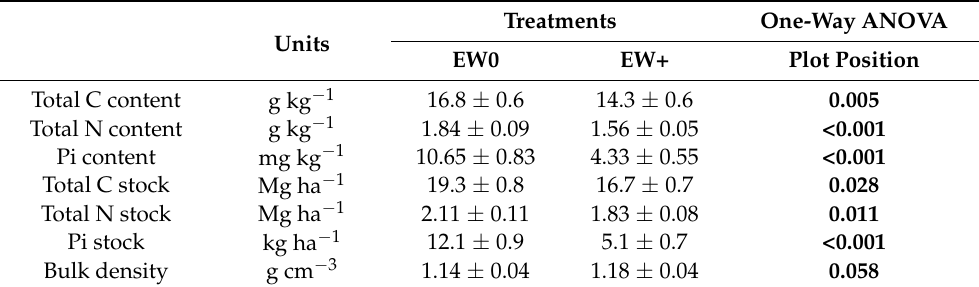
Table 1. Mean ± SE and one-way ANOVA statistics for soil variables measured at the beginning of the experiment (2013). Treatments are abbreviated as follows: EW0: treatments where earthworms will not be inoculated, EW+: treatments where earthworms will be inoculated. Significant p -values are in